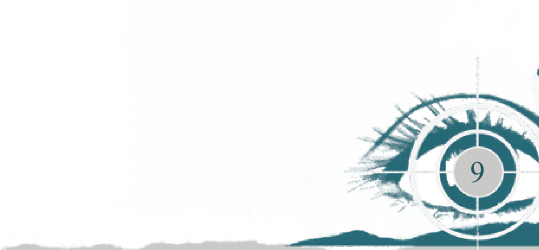
Figure 6 Locator lines and cardinal points for S, the visual system ( L 0 , L 1 , F 0 , P, N and F 1 ), and for S C , the combination of thin contact lens and visual system ( L C0 , L C1 , F C0 , P C , N C and F C1 ). In this case the eye is hyperopic and the contact lens compen- sates for the refractive error. The effect of the lens is to cause the locator lines to rotate about 1 = X on entrance plane T 0 . The principal points remain fixed while other cardinal points and, in fact, all other special points, shift towards T 0 in proportion to their distances from T 0